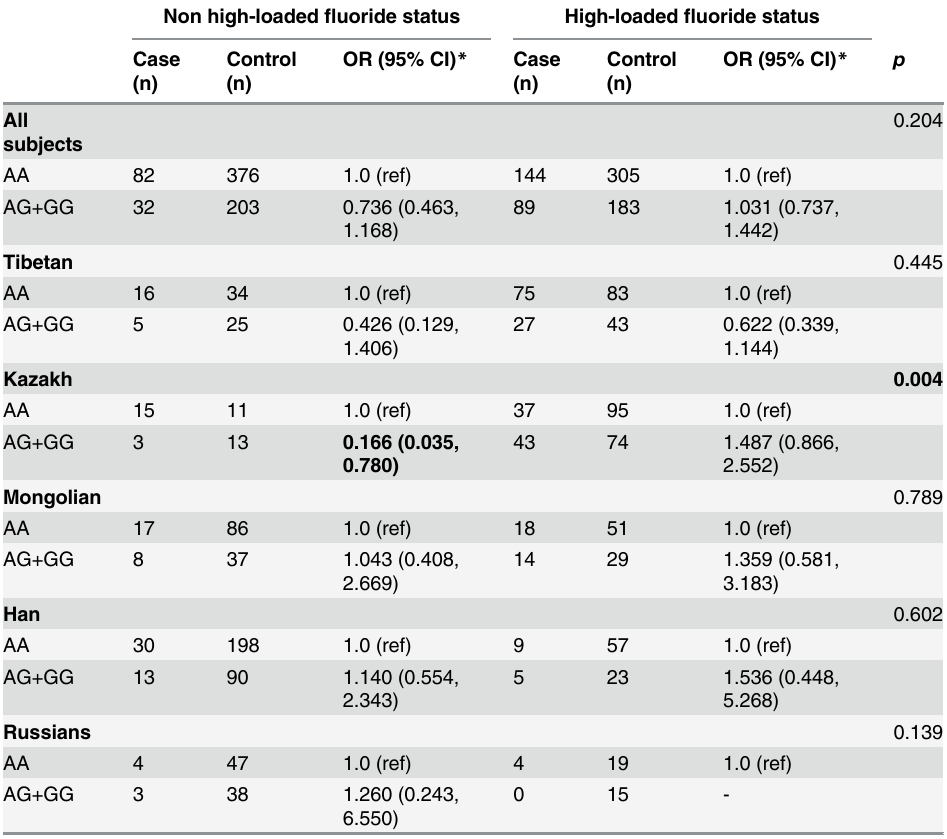
Table 5. Risk of skeletal fluorosis associated with GSTP1 Rs1695 in subjects, stratified by fluoride ex- posure